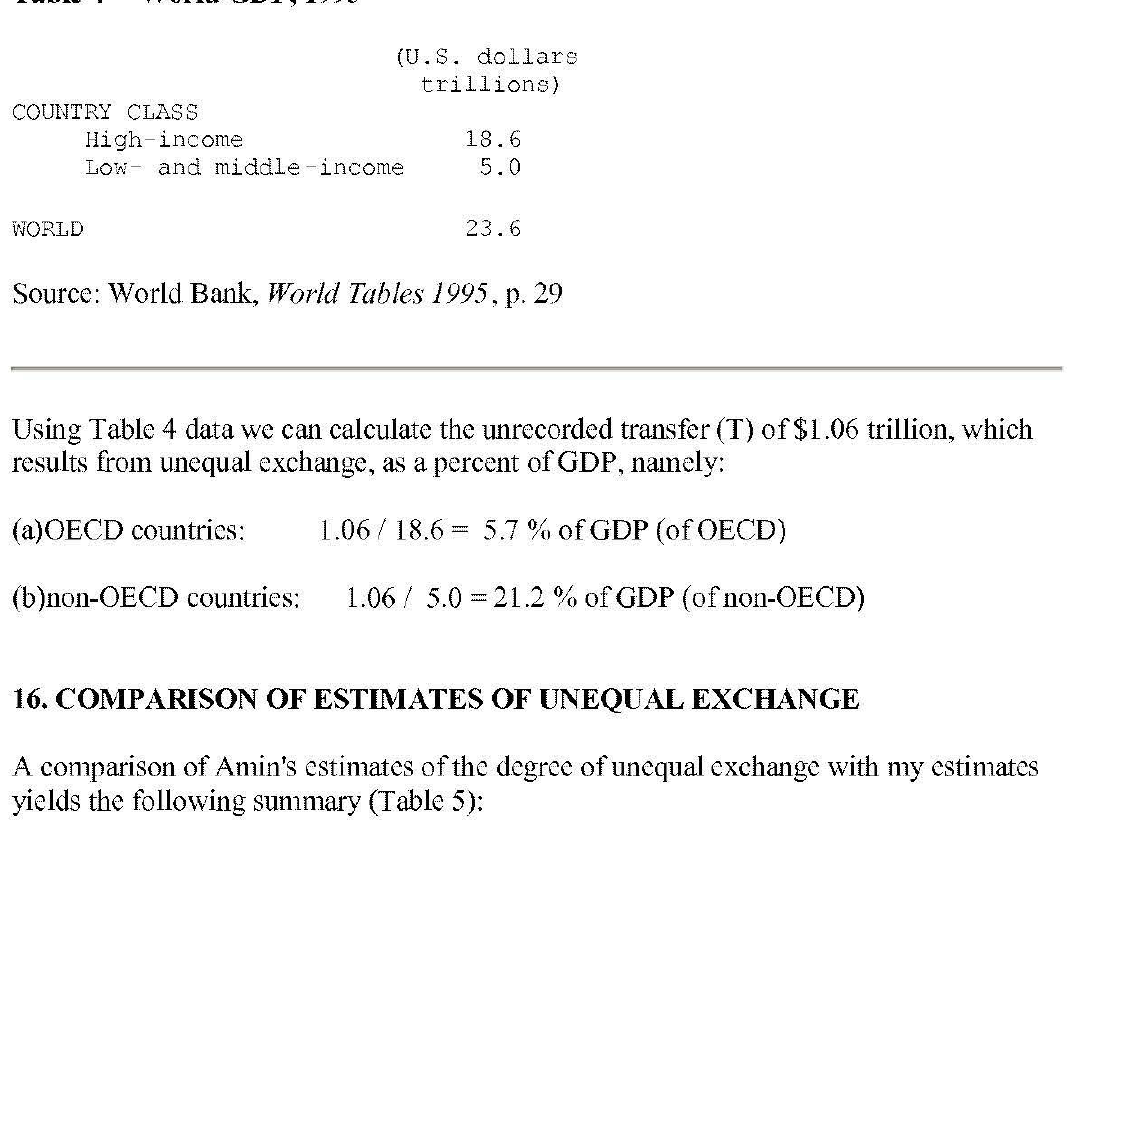
Table 4 - World GDP, 1993 (U. S. do ll ars t r illion s ) COUNTRY CLASS High-i ncome 18 . 6 Low- an d mi dd l e -in come 5 .0 WORLD 23 .